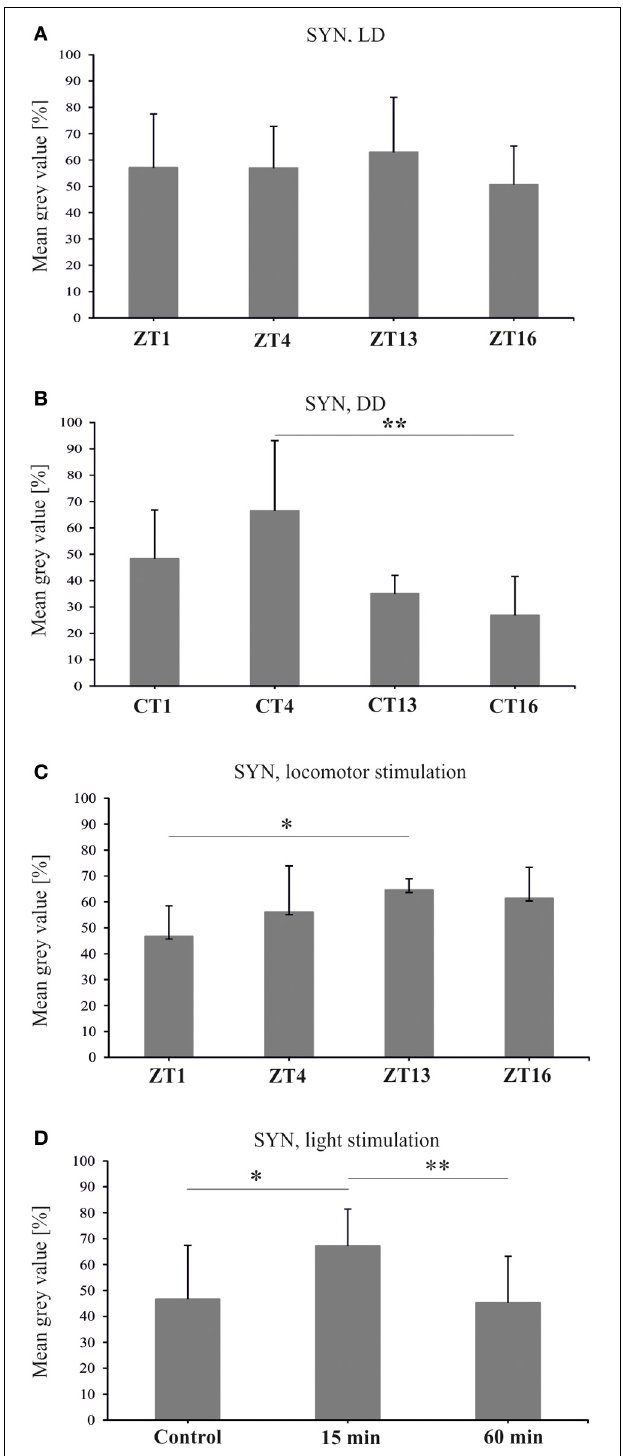
FIGURE 5 | Synapsin-specific immunofluorescence (brightness) measured from confocal images of the fly’s lamina. The level of this protein is the same during the day and night of LD 12:12 (A) , oscillates in constant darkness (B) , changes after 1h of locomotor stimulation (C) and increases after 15min of light stimulation (D) ( ∗ p ≤ 0 . 05, ∗∗ p ≤ 0 . 01).